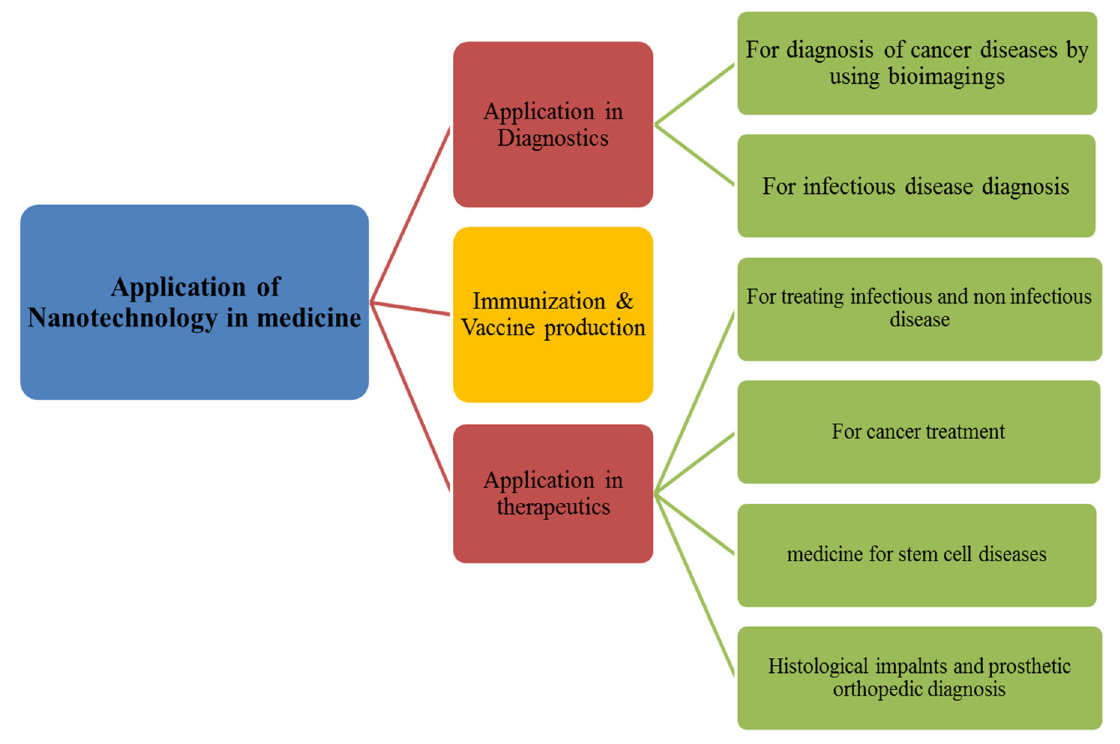
Figure 3. Application of nanotechnology in medical science [9].